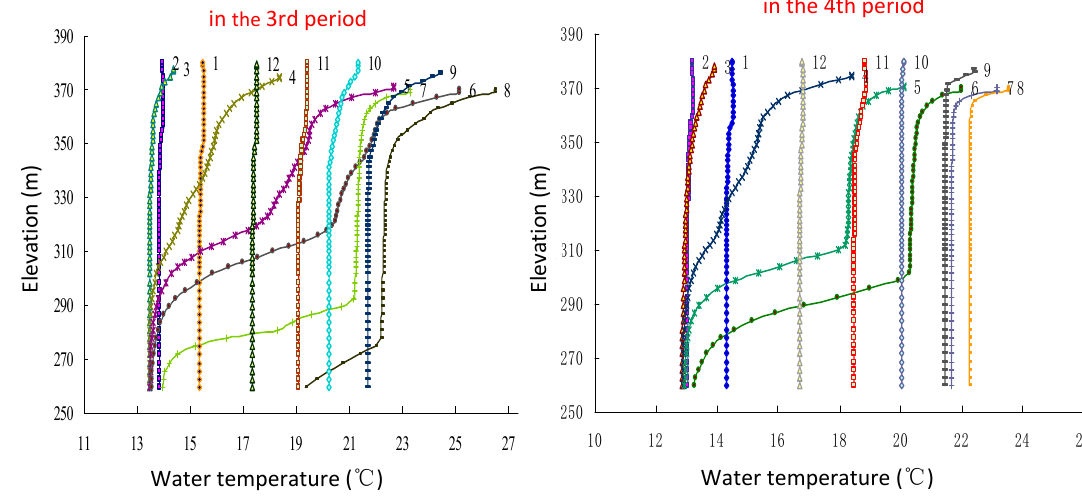
Figure 5. Vertical water temperature distribution in front of the XJB dam (1: January; 2: February; 3: March; 4: April; 5: May; 6: June; 7: July; 8: August; 9: September; 10: October; 11: November; 12: December).